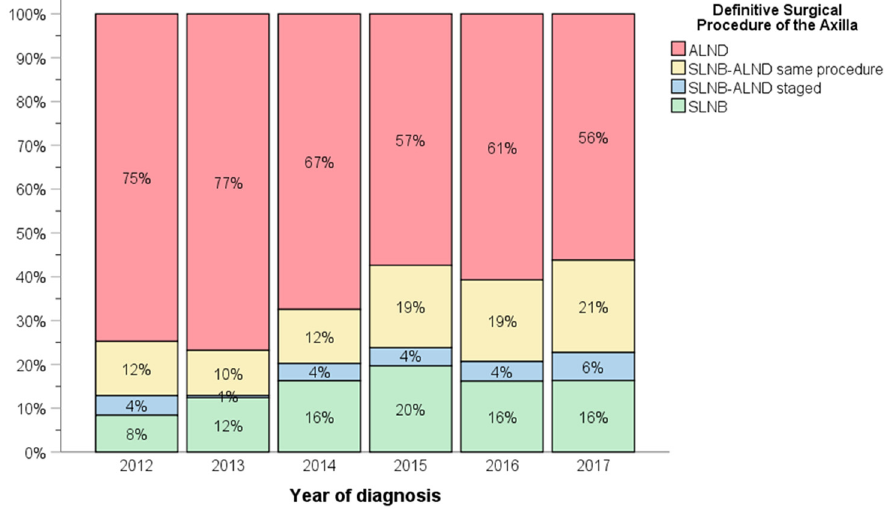
Figure 2. Chronological trends of the definitive surgical axillary procedure between 2012–2017.